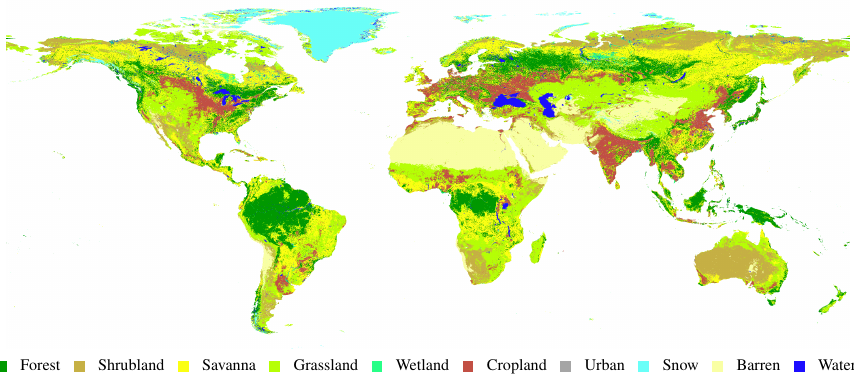
Figure 1. The MODIS-derived world map at a resolution of 500 m following the simplified IGBP scheme. While larger areas of the Savanna class (in yellow color) are found in South America, Africa and Australia as expected, there are also vast areas of Savanna in Canada, Scandinavia, and Siberia – regions in which savannas in the geographical sense of the term usually do not